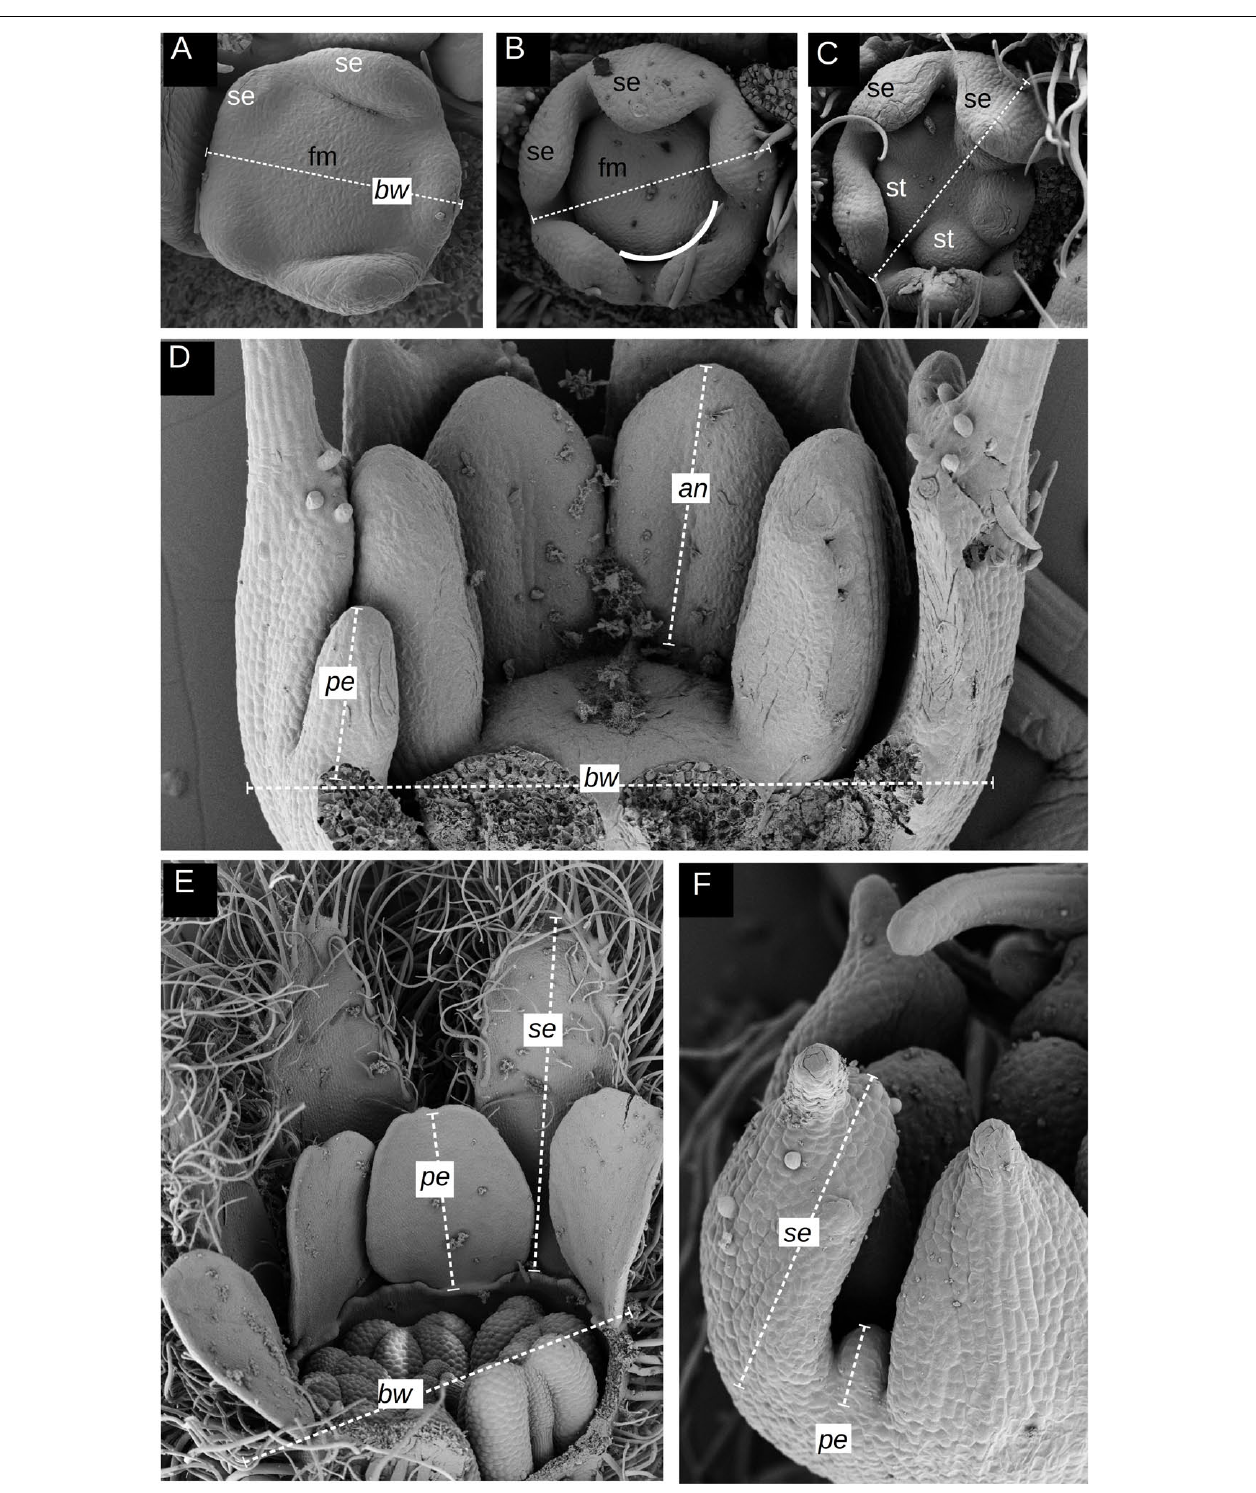
FIGURE 2 | Developmental stages and measurements taken. (A–C) definition of stages I–III on polar views; the key organs or attributes whose presence defines the respective stage marked in white. (D–F) Examples of measurements obtained from lateral views. (A) M. linearifolia (Radiate) showing stage I defined by the presence of a bare floral meristem (fm) surrounded by five just initiated sepal primordia (se). The dashed line represents the measurement of the bud width ( bw ) from the tip of